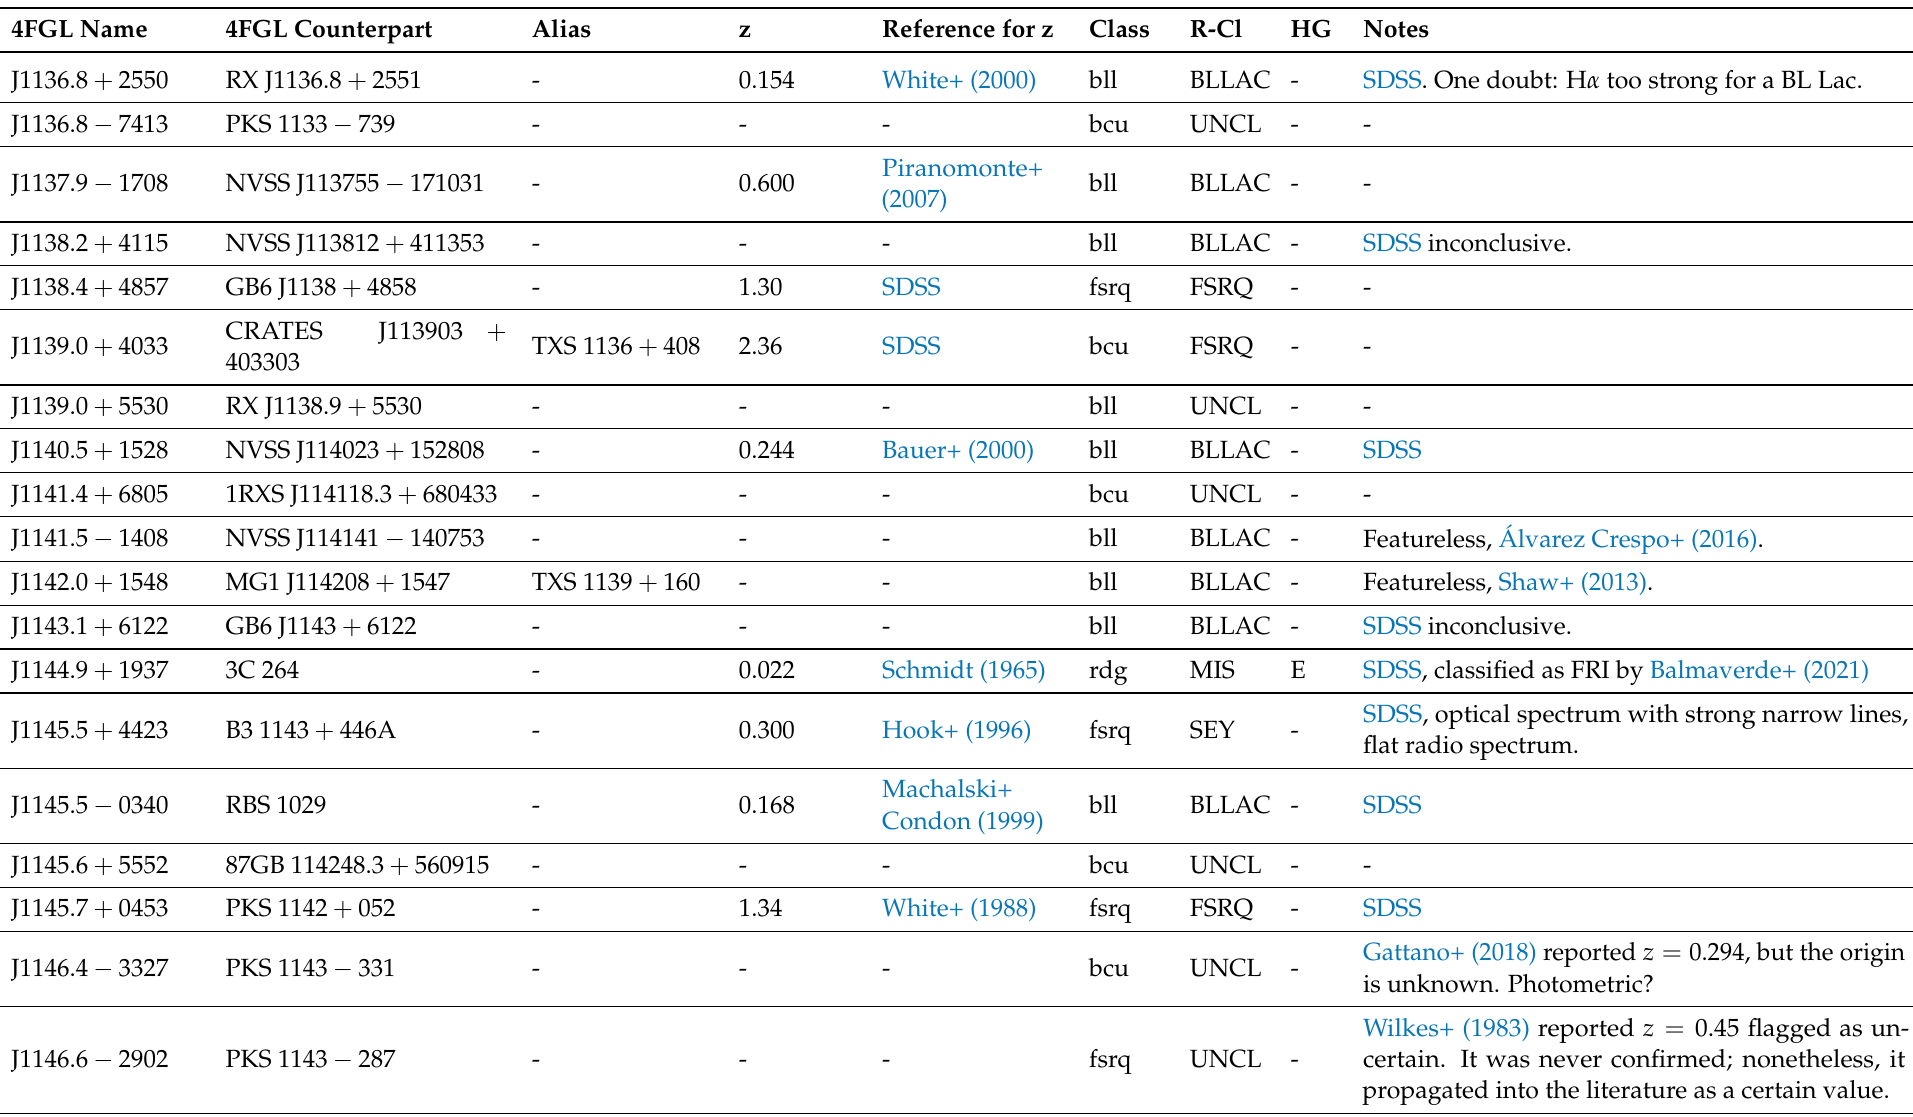
Gattano+ (2018) reported z = 0.294, but the origin - is unknown. Photometric? Wilkes+ (1983) reported z = 0.45 flagged as un- - certain. It was never confirmed; nonetheless, it propagated into the literature as a certain